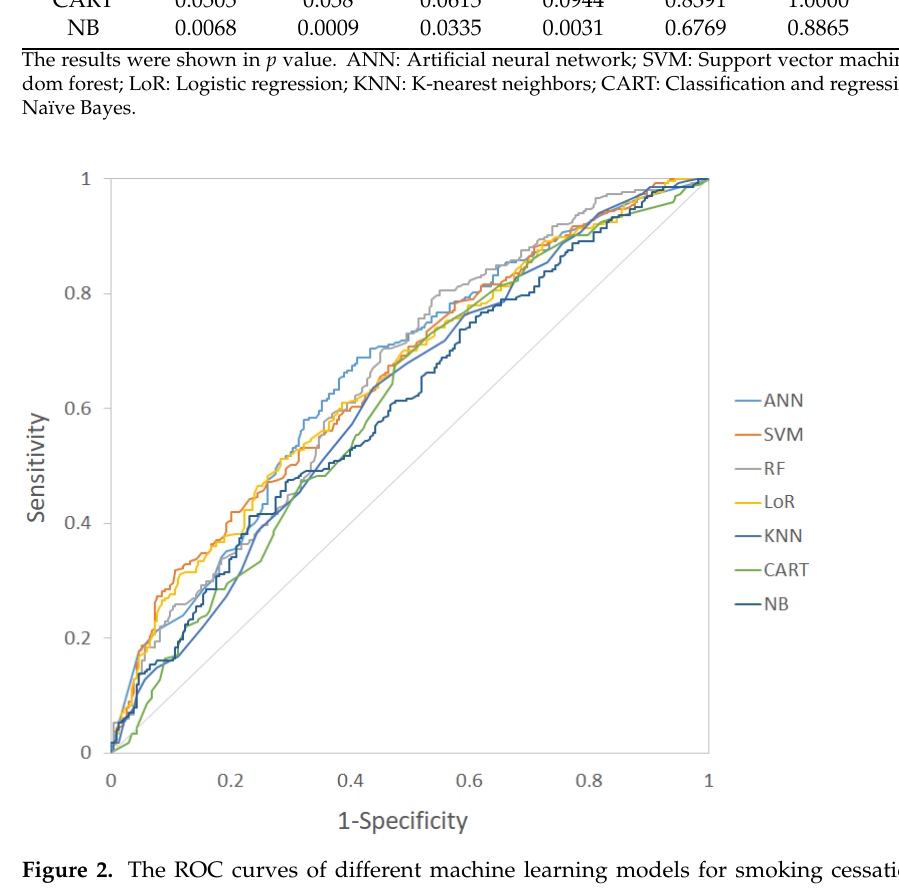
Figure 2. The ROC curves of different machine learning models for smoking cessation. ANN: Artificial neural network; SVM: Support vector machine; RF: Random forest; LoR: Logistic regression; KNN: K-nearest neighbors; CART: Classification and regression tree; NB: Naïve Bayes; ROC curve: Receiver operating characteristic curve.